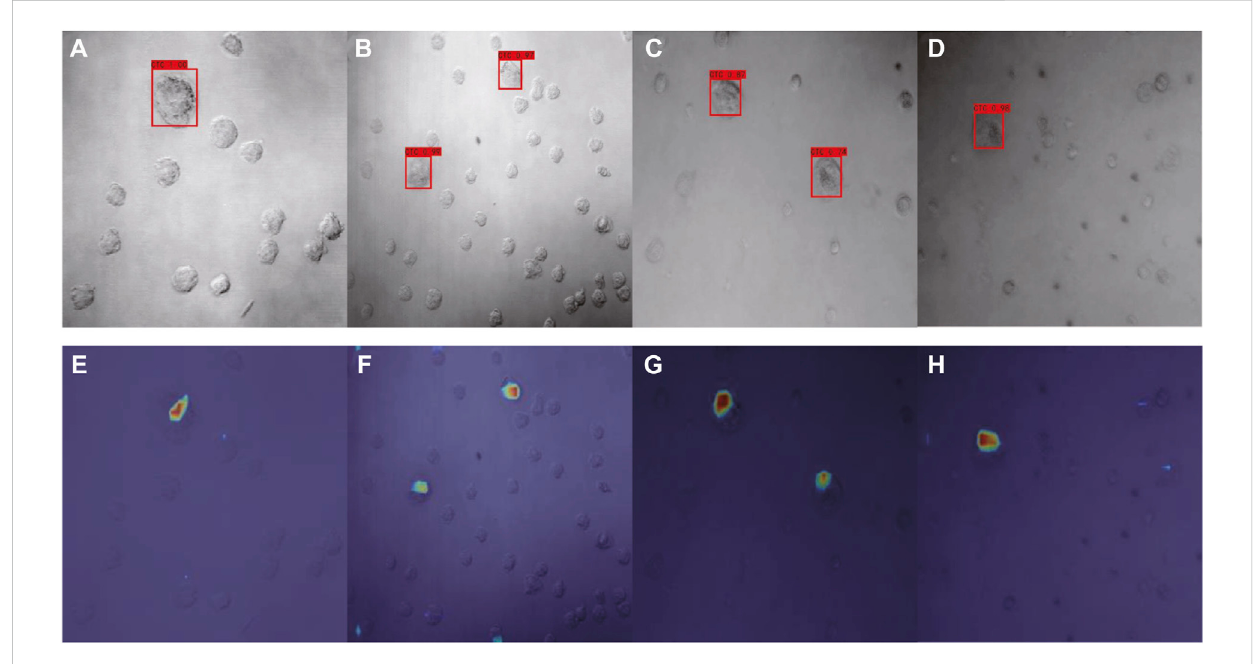
FIGURE 7 Detection results of optimized SSD (A – D) and the corresponding interpretation obtained by Grad-CAM (E – H) for Dataset I.